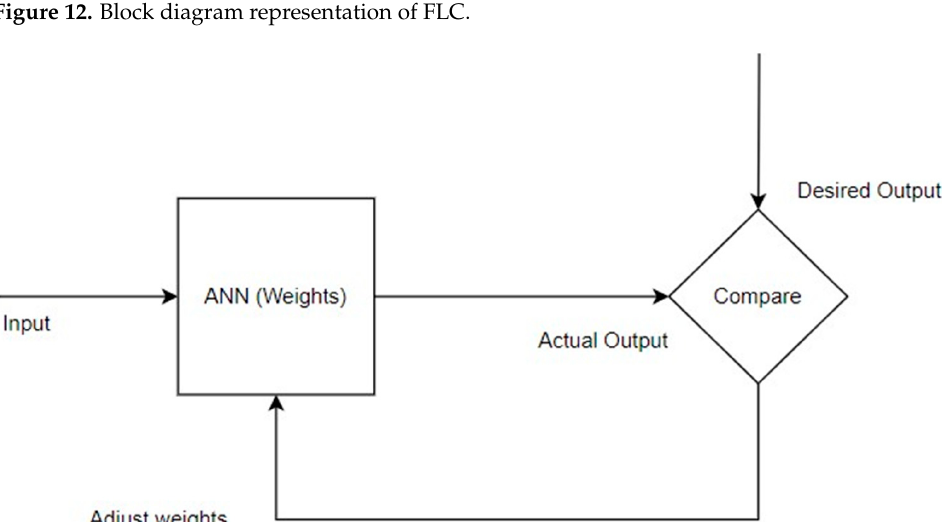
Figure 13. Block-diagram representation of ANN.